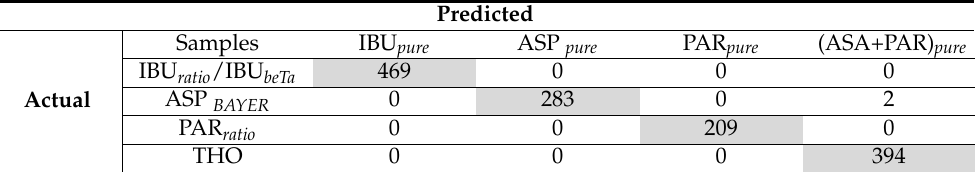
Table 4. Classification of the painkiller tablets based on the pure API